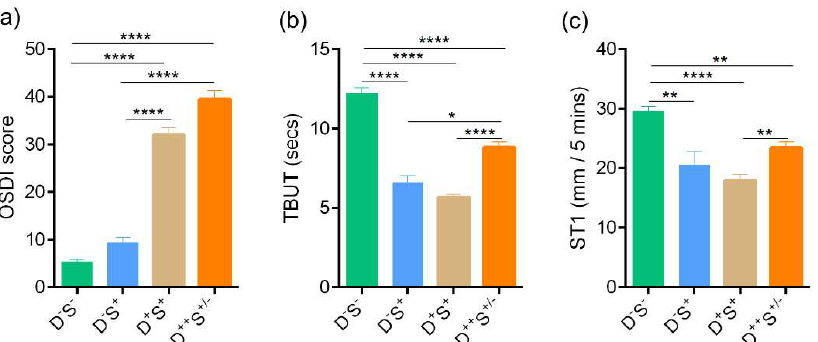
Figure 3. Ocular surface disease index score, Tear break up time, and Schirmer’s test values in subjects categorized based on discomfort concordance to signs (DCS) grouping strategy. Bar graphs represent ( a ) Ocular surface disease index (OSDI) scores indicative of the discomfort/symptoms, ( b ) Tear break up time (TBUT) values in secs—indicative of sign and ( c ) Schirmer’s test (ST1) values in mm/5 min—indicative of sign in the study subjects grouped in the various categories based on DCS grouping strategy. Group 1 (D - S - ): n = 58 eyes; Group 2 (D - S + ): n = 28 eyes; Group 3 (D + S + ): n = 127 eyes; Group 4 (D ++ S +/- ): n = 74 eyes. * p < 0.05, ** p < 0.01, **** p < 0.0001. Kruskal–Wallis test with